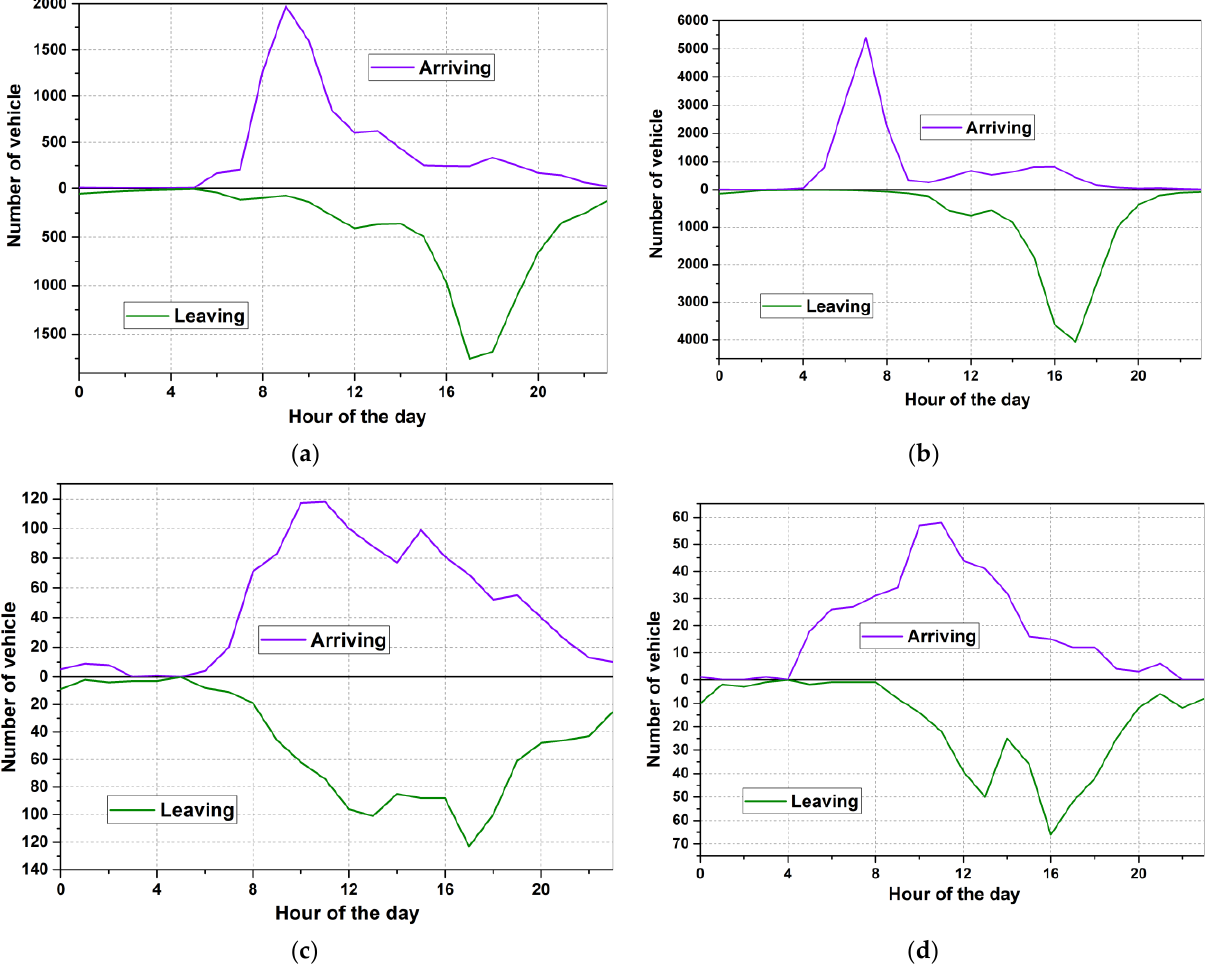
Figure 4. Hourly arrival and departure of vehicles. ( a ) Caltech weekday. ( b ) JPL weekday. ( c ) Caltech weekend. ( d ) JPL weekend.